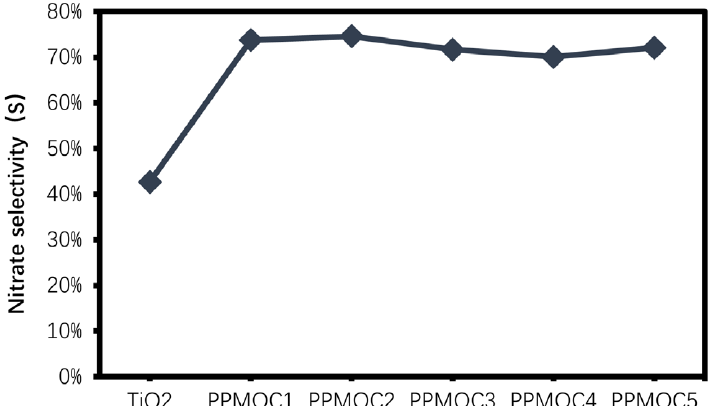
Figure 8. Nitrate selectivity of different porosity samples. The PPMOC number in x axis means different porosity (shown in the experimental section).